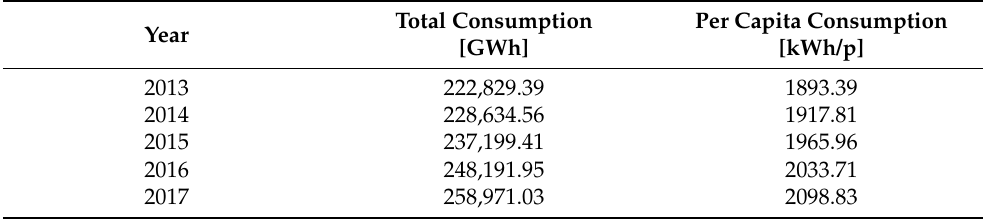
Table 3. Total consumption and per capita consumption of electricity. Source: Own elaboration with data from